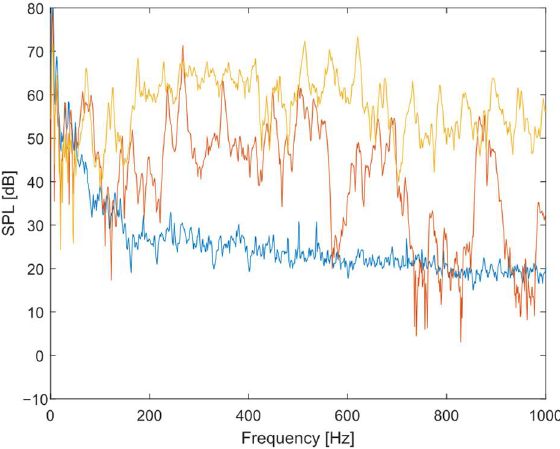
Figure 16. SPL spectra measured at 0.5 m from the outlet for the background noise (blue), 3 m long straight pipe (yellow), and the silencer system (orange).